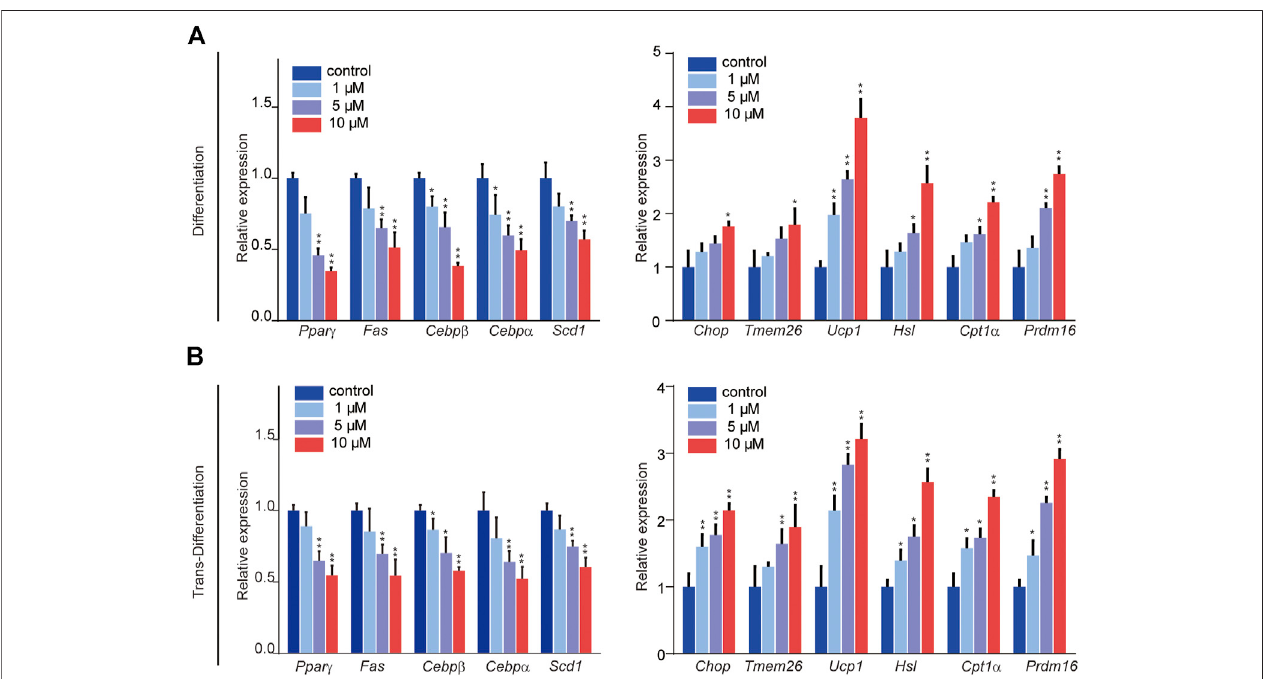
FIGURE2| EffectsofSFNontheexpressionofkeyadipocyte-speci fi cmarkers (left) andbrowning-speci fi cmarkers (right) inC3H10T1/2adipocytes. (A,B) Total RNAwasextracted attheendofthedifferentiationand trans-differentiationprocesses. mRNAexpressionwasanalyzedbyreal-timeqPCR.Theresultswerenormalized to β -actin. All the results were expressed in graph with mean ± SD. Statistical signi fi cance was evaluated by Student t test. * and ** represent the signi fi cant difference at p < 0.05, p < 0.01 vs control group.